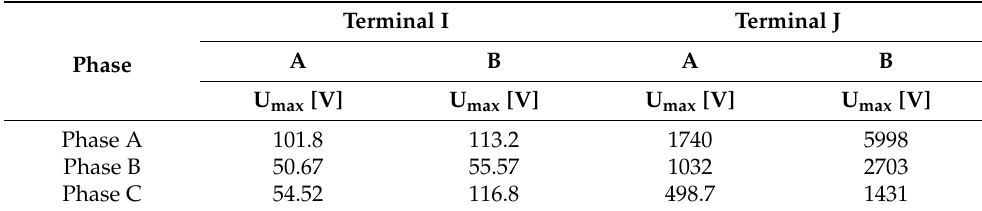
Table 2. Maximum overvoltage for cable line configuration.